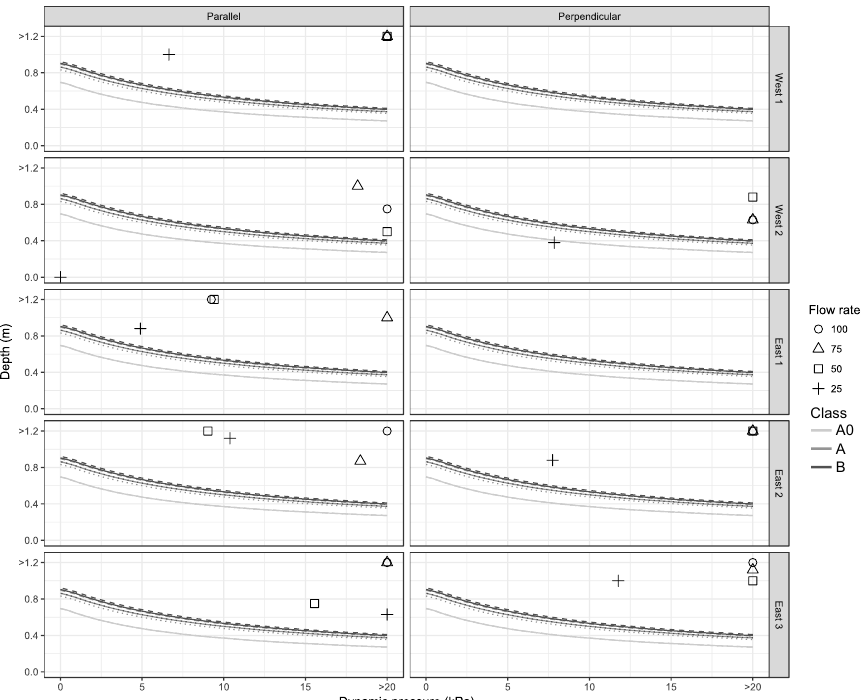
Figure 10. Critical depth–pressure curves for building classes A0, A and B subjected to a hyperconcentrated flow. Peak normal pressures and corresponding depths applied to each city block are plotted as points for each flow